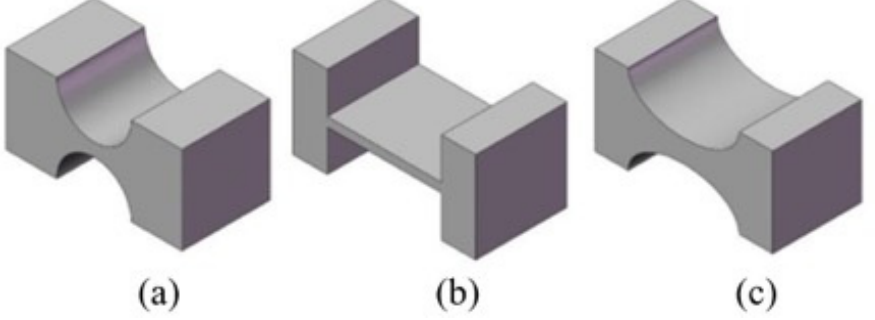
Figure 2. Three common notched flexure hinges: ( a ) Straight-circular flexure hinge; ( b ) straight-beam flexure hinge; ( c ) elliptical flexure hinge.